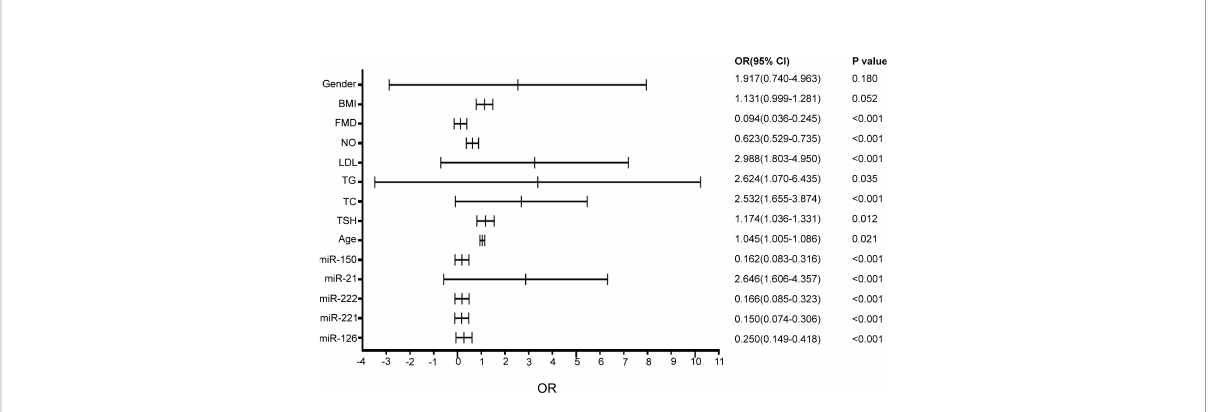
FIGURE 4 The variable parameters of affecting atherosclerosis. The horizontal lines indicate the OR (Odds Ratio). The dotted lines indicate the variable parameter value. P< 0.05 was de fi ned signi fi cant. OR, Odds Ratio; 95% CI, 95% con fi dence